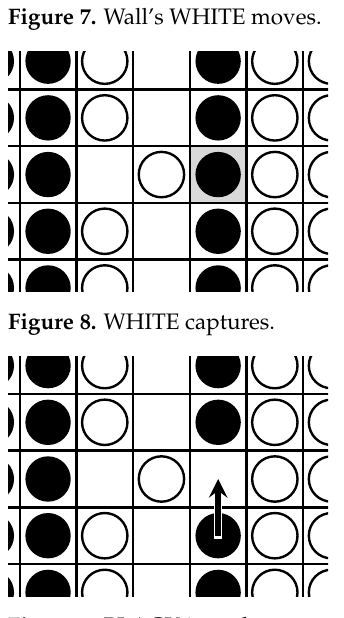
Figure 9. BLACK intrudes.